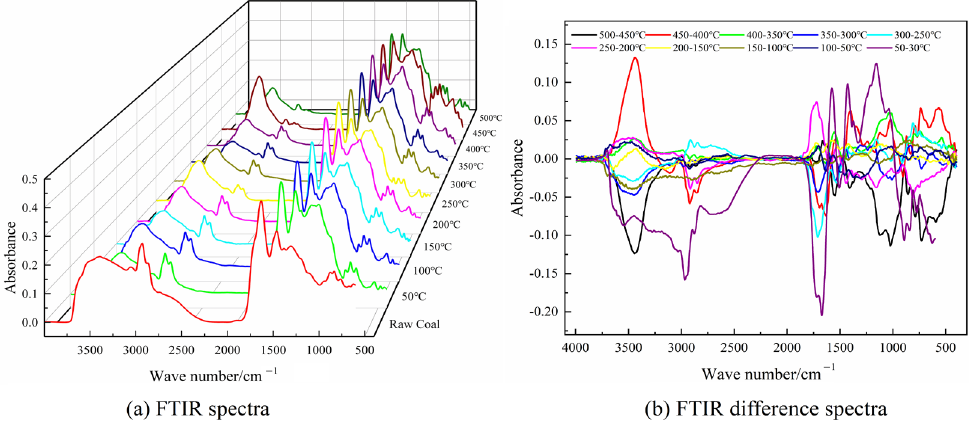
Figure 11. Original FTIR spectra ( a ) and FTIR differences of spectra ( b ).